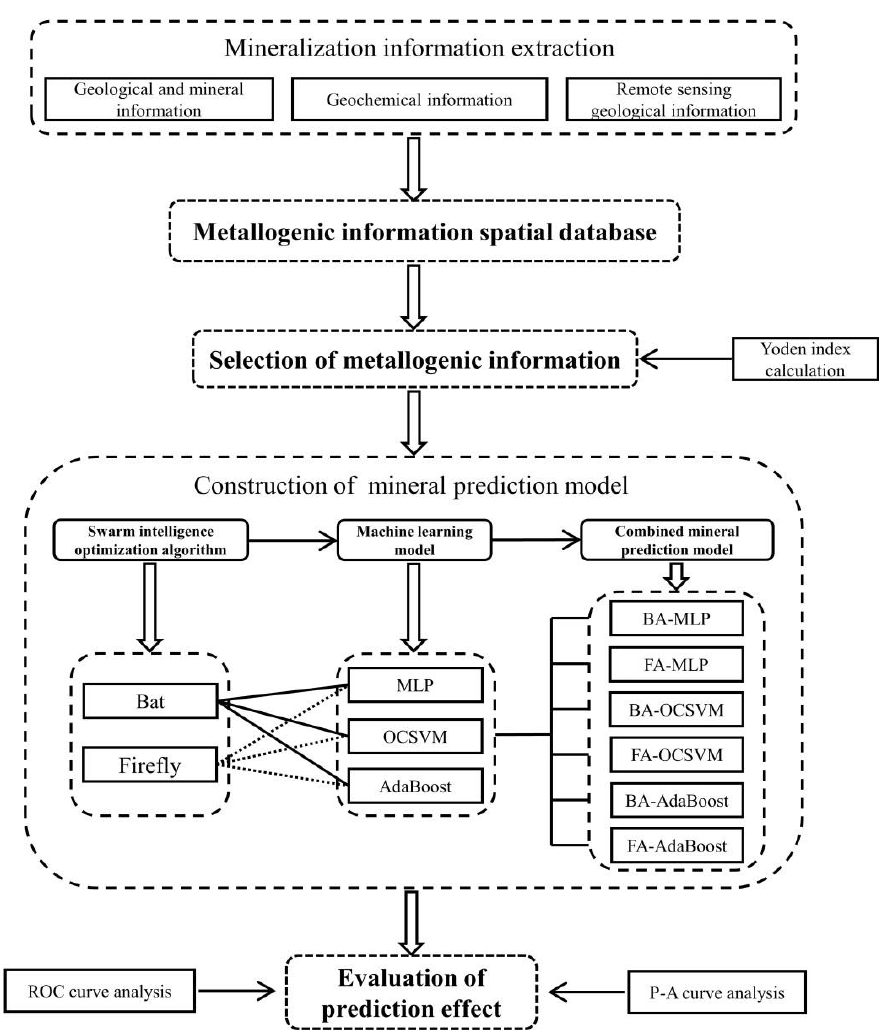
Figure 1. Calculation process of mineral potential.